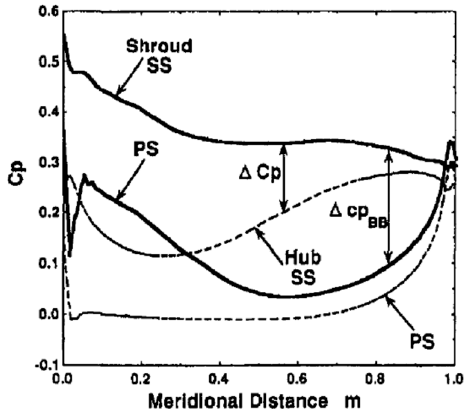
Figure 4. Calculated pressure coefficient Cp distribution on both the pressure surface and suction surface at the shroud and hub, respectively, for the conventional impeller [43].